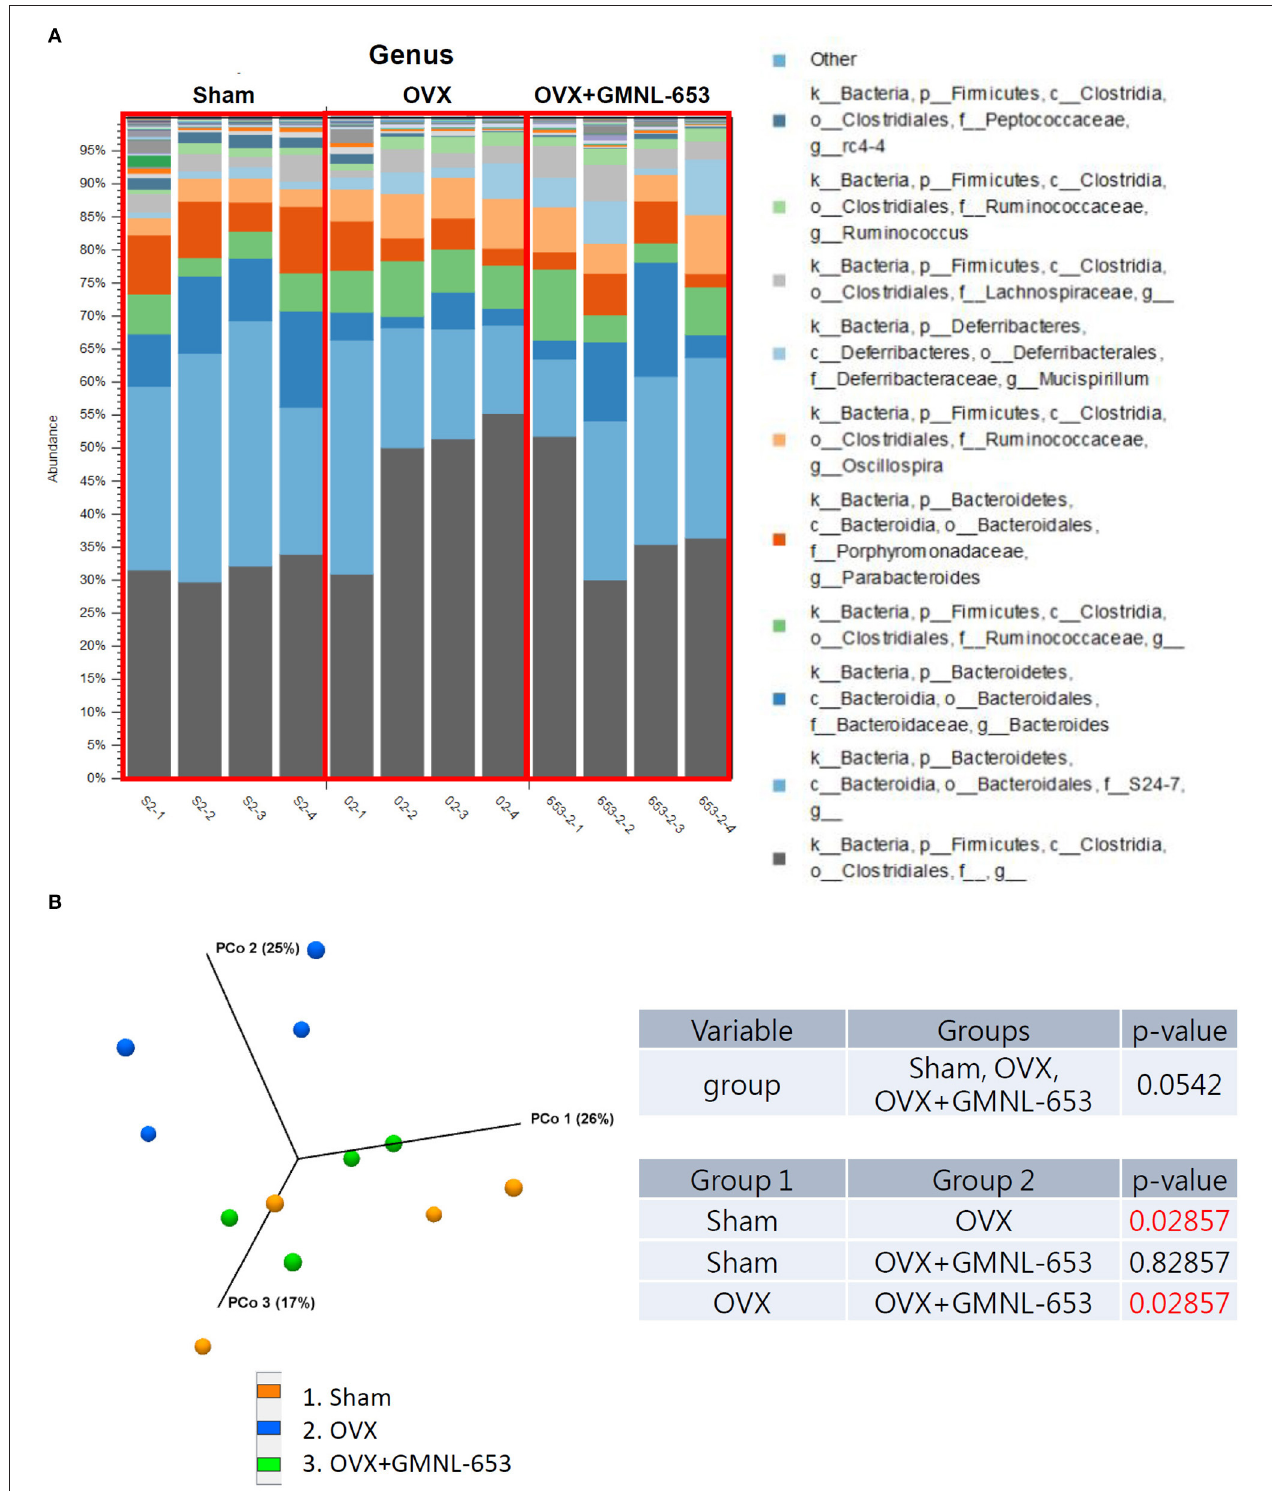
FIGURE 4 | Relative abundance and diversity of stool microbiota in the sham and OVX mice treated with either the vehicle (H 2 O) or heat-killed GMNL-653. (A) Each column in the stacked histogram represents one sample; the differently colored bars are proportional to the percentage of relative bacterial abundance of each taxon within the sample (summing up to 100%). (B) Principal coordinate analysis of the beta diversity among the three groups.